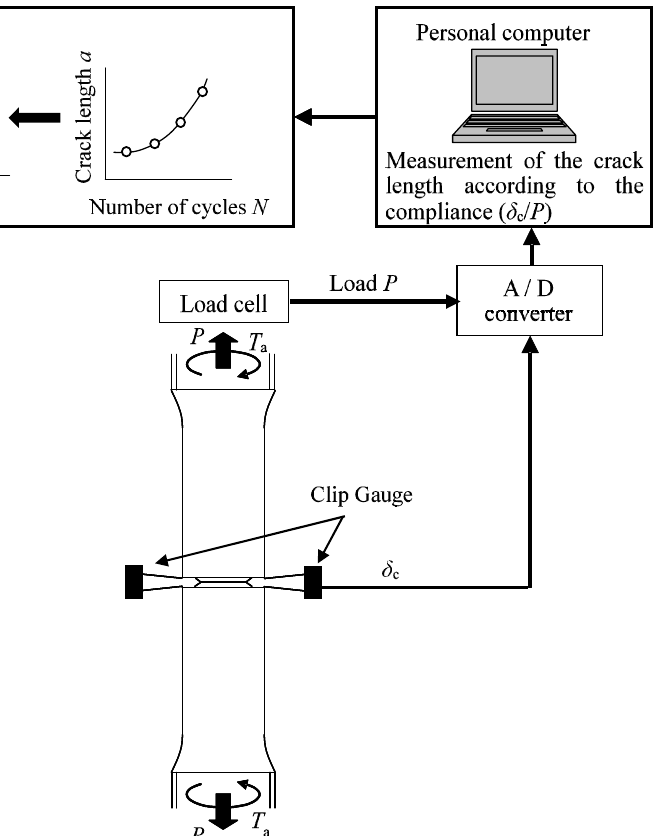
Figure 3. Measurement system for the fatigue crack growth rates.